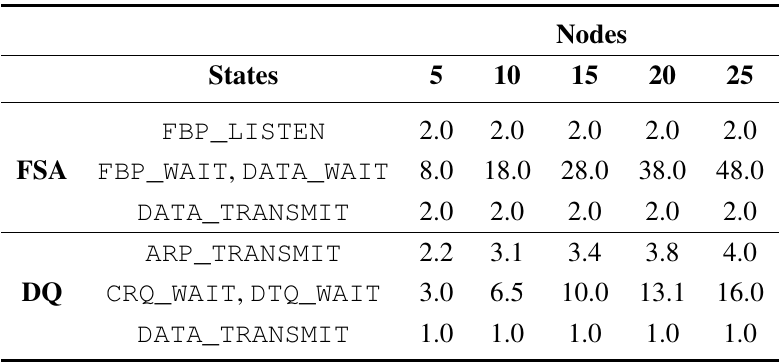
Table 3. Average number of states for Frame Slotted ALOHA (FSA) and